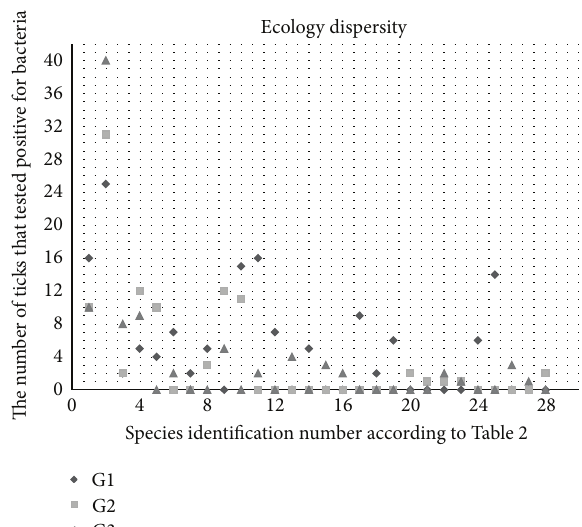
Figure 2: The scatter plot shows the distribution of bacterial species from groups G1, G2, and G3. Species are identified in the figure with a number corresponding to the species number in Table